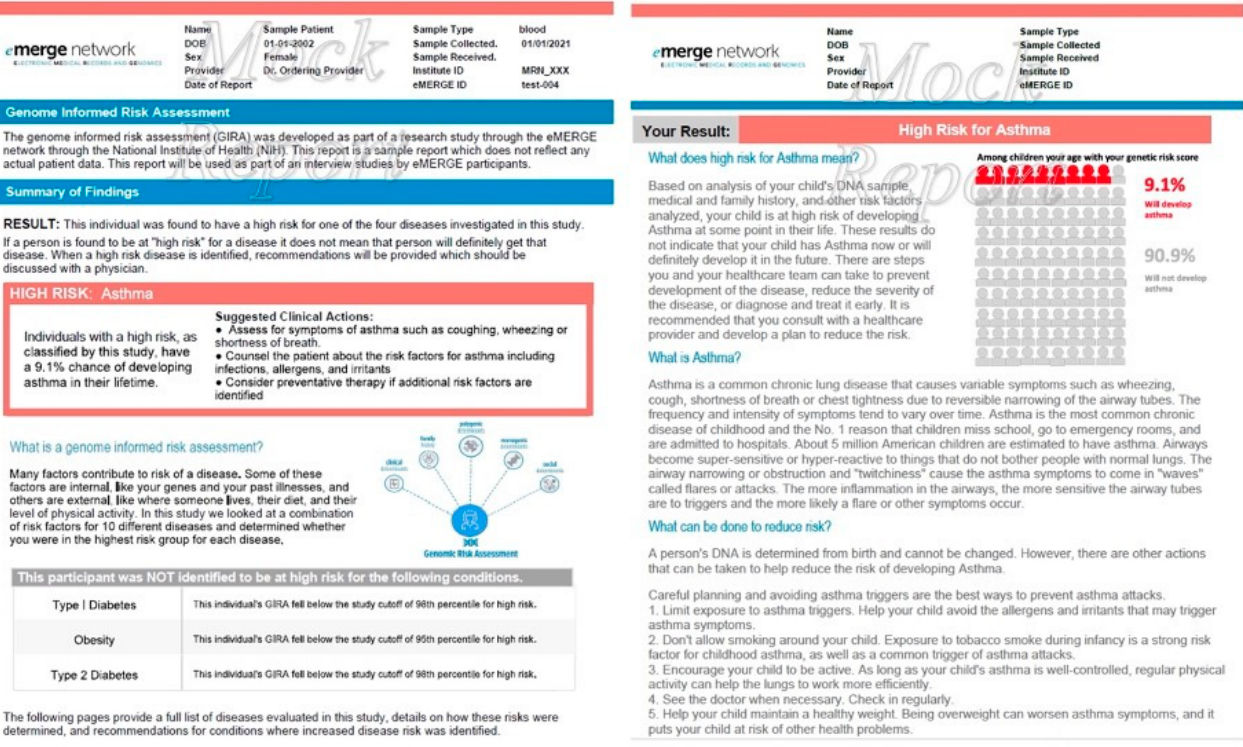
Figure 1. Mock GIRA report for high risk asthma presented as an absolute risk. The report is modeled off the return of results report to be used in eMERGE 4.